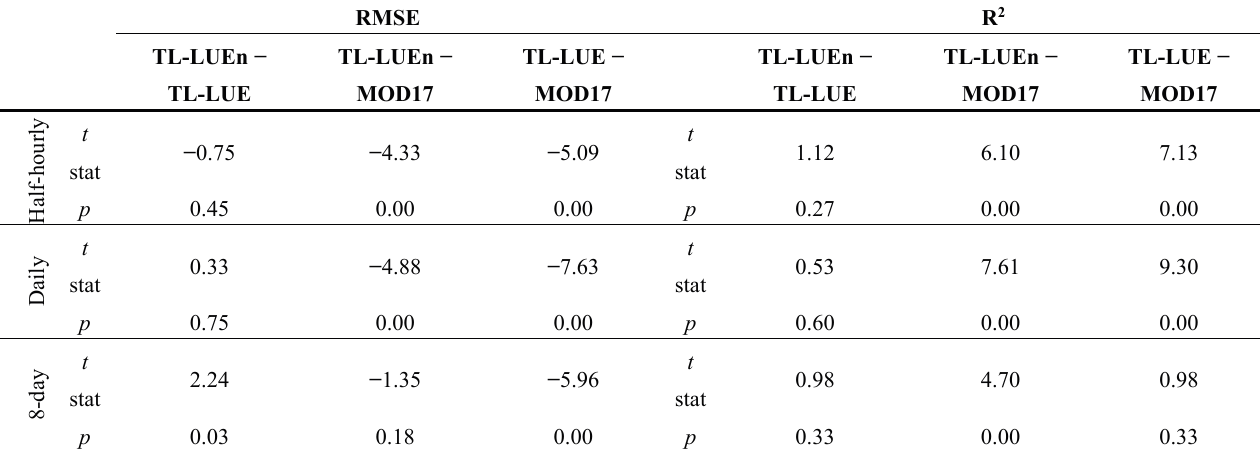
Table 4. Statistics of the Paired t Tests on the differences between TL-LUEn and TL-LUE, TL-LUEn and MOD17, and TL-LUE and MOD17 in RMSE and R 2 for model validation when all vegetation types lumped together at half-hourly, daily and 8-day scale. RMSE R